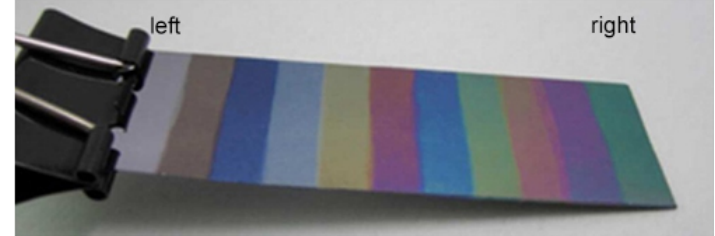
Figure 6. PVDF LB nanofilms with different layers, from 0 ( left ) to 200 ( right ) layers [61].